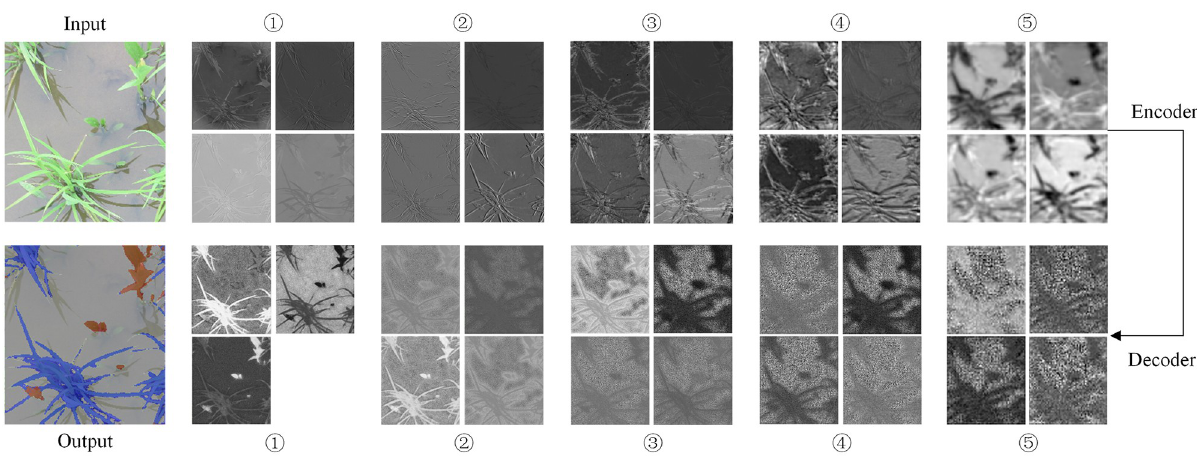
Fig 5. Feature map visualization of the convolutional